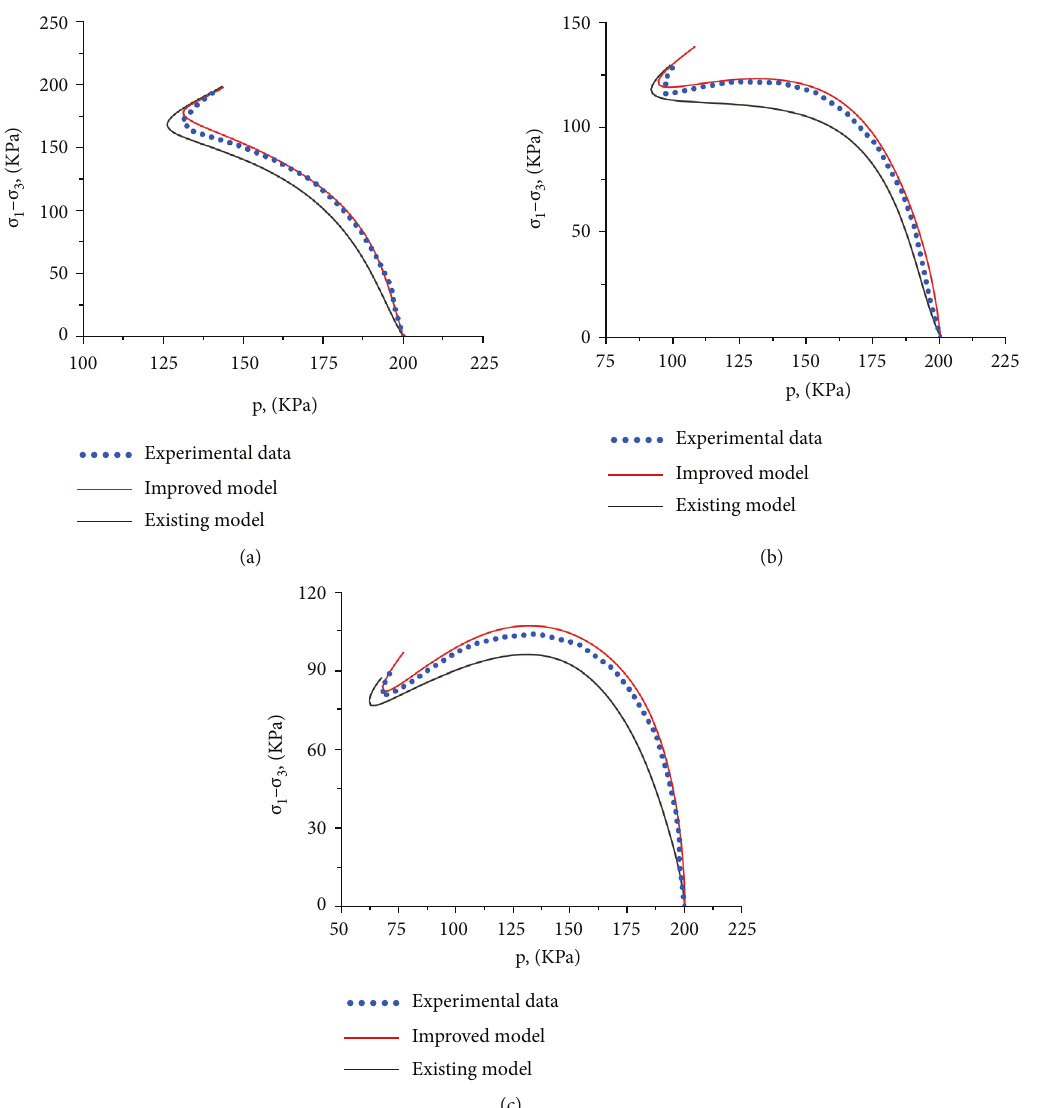
Figure 14: Comparison of two models and the experimental results by Uthayakumar and Vaid [50] for undrained triaxial tests (stress path response): (a) θ =0 ° ; (b) θ =30 ° ; (c) θ =60 °